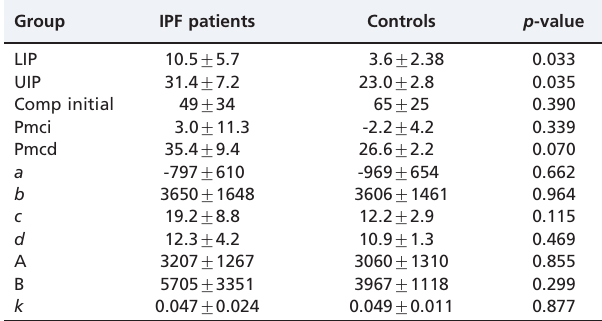
Values are shown as means ¡ SD. IPF= Idiopathic pulmonary fibrosis; LIP = lower inflection point; UIP = upper inflection point; Comp initial= initial compliance (from EELV to 8 ml/kg IBW) shown in ml/cm H 2 O; Pmci= pressure of maximal compliance increase, mathematically defined as c - 1.317 d , in cm H 2 O ; Pmcd= pressure of maximal compliance decrease, mathematically defined as c + 1.317 d , in cm H 2 O; a = sigmoidal equation parameter representing the difference in volume between EELV and residual volume; b = volume from a to the upper asymptote approximating vital capacity; c = pressure at the mathematical sigmoidal inflection point; d is proportional to the pressure range at which most of the volume change occurs, measured in cm H 2 O; A= asymptote approximating total lung capacity; B= volume below A at which the pressure is zero, approximating inspiratory capacity; k = exponential constant that describes the shape of the